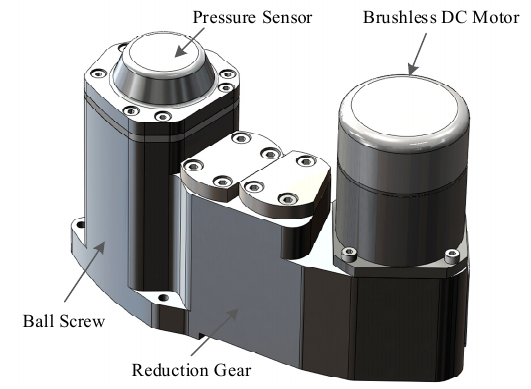
Figure 4. Structure of the EMA.